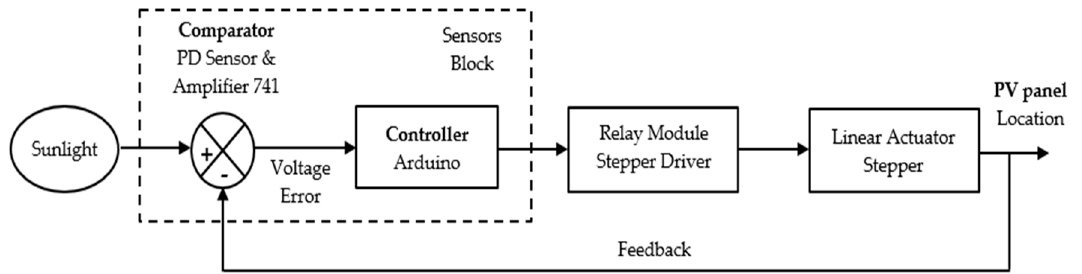
Figure 6. Closed loop blocks diagram of tracking system.